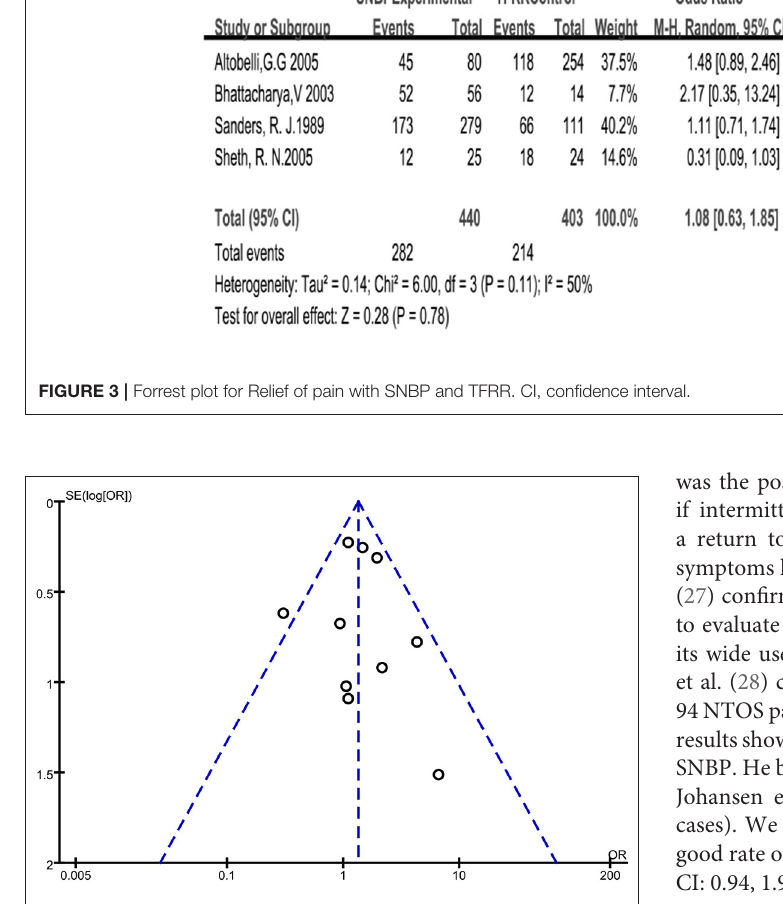
FIGURE 4 | Funnel plot for improvement of upper limb function with